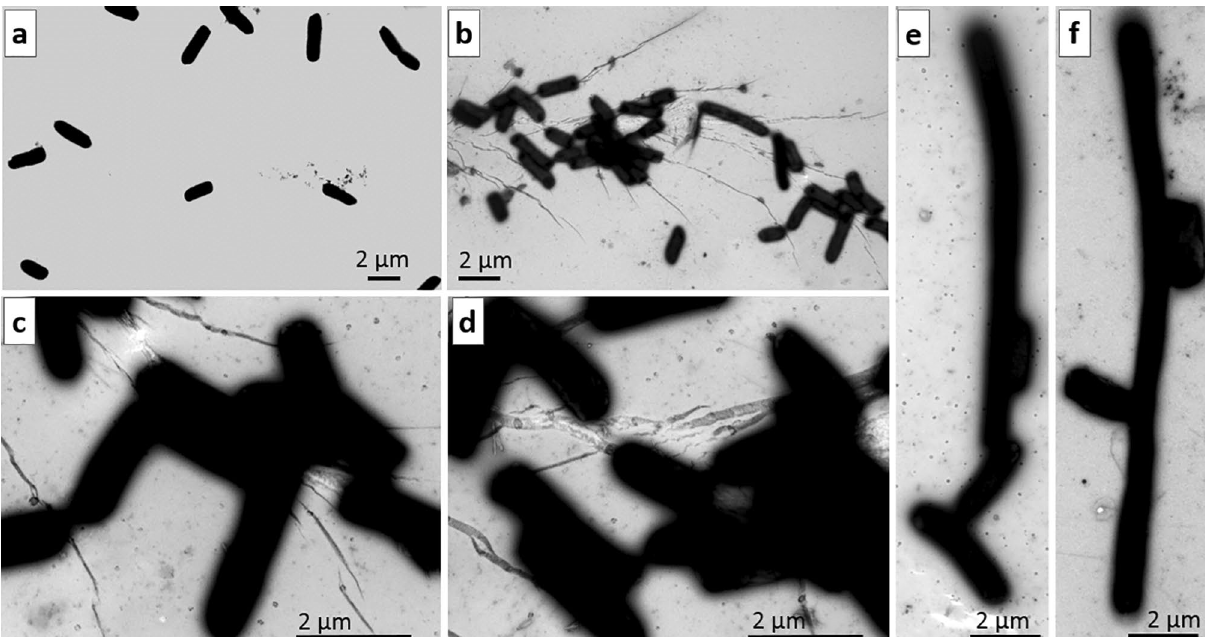
Figure 1. Aggregation of E. coli cells after treatment with THz radiation. ( a ) Stand-alone bacteria in the unirradiated sample. ( b ) Agglomeration of aggregated bacteria after the irradiation. ( c,d ) Magnified parts of panel ( b ). ( b–f ) Examples of aggregation of short and elongated (filamentous) bacteria. ( b–d ) Bacteria aggregate via side surfaces. ( e,f ) Bacteria aggregate through apical regions. The scale bar is 2 µm. Negative